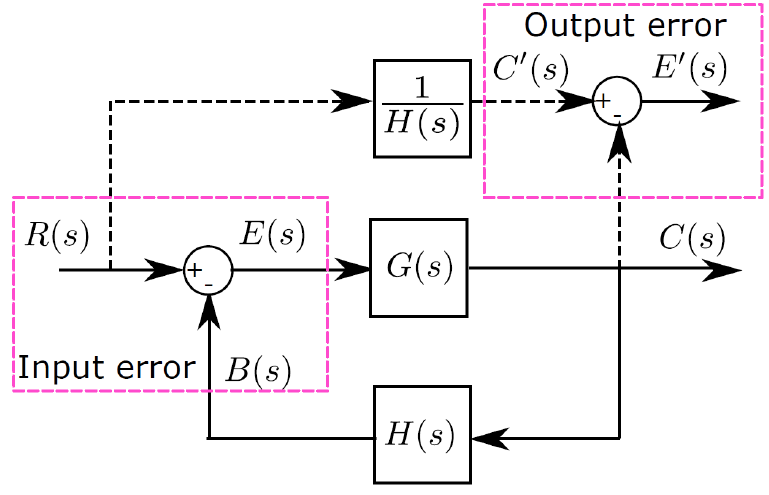
Figure 3. Feedback control system with input and output error